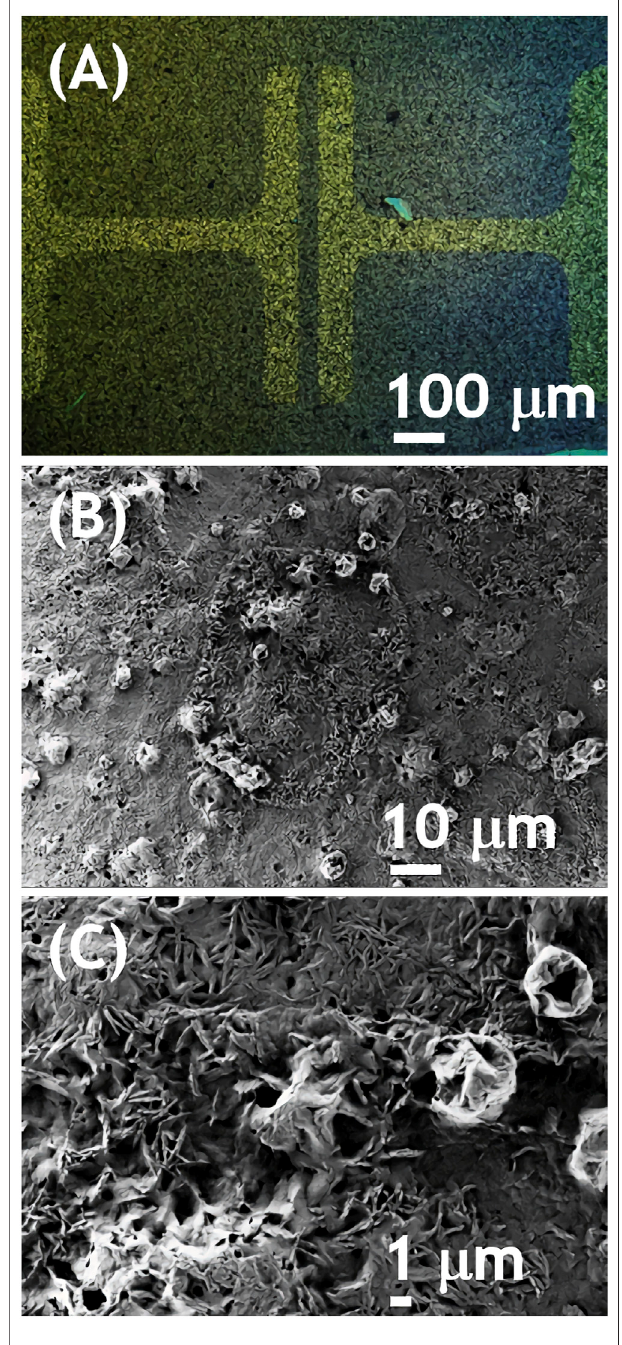
FIGURE 2 | Optical (A) and scanning electron (B, C) micrographs of NDIC8:P3HT spray-coated on an OFET substrate.